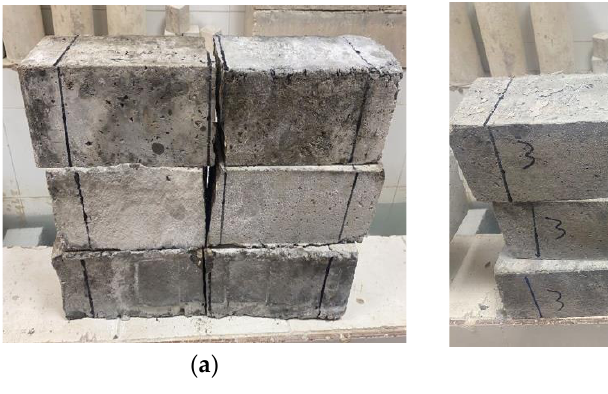
Figure 8. Typical flexural failure modes at room temperature ( a ) Control specimen, ( b ) Hybrid fiber reinforced concrete specimens, ( c ) Mono fiber reinforced concrete specimens.